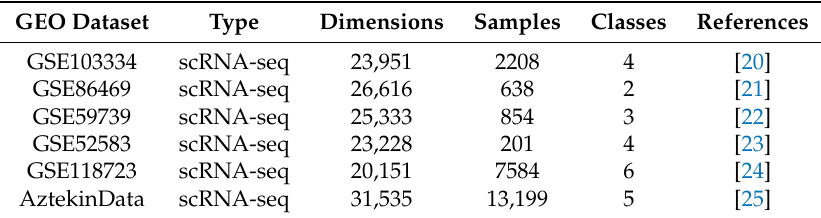
Table 1. Attributes of transcriptomics experimental